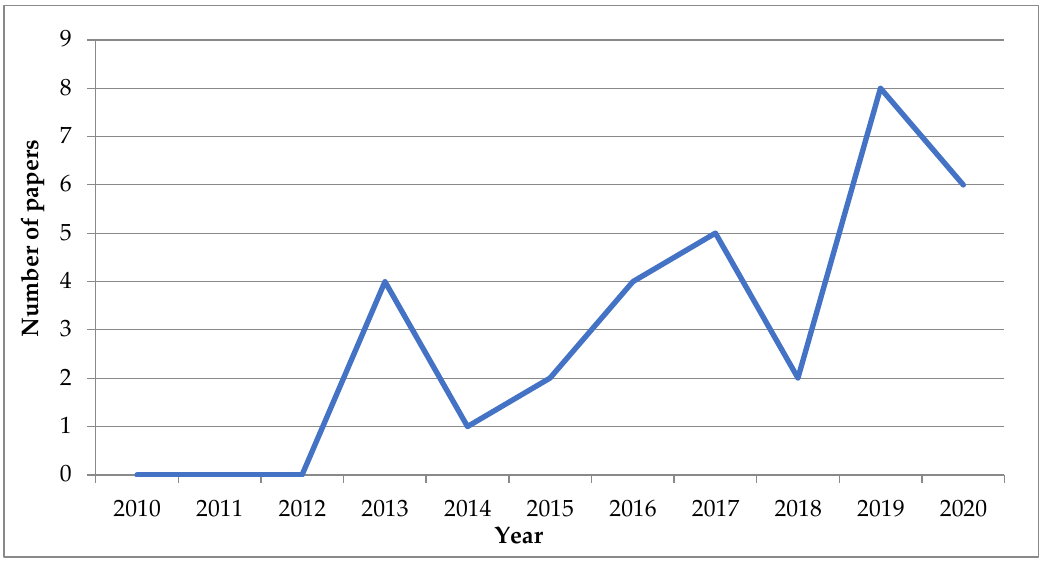
Figure 2. Number of publications per year (2010–2020). (Source: our elaboration.)